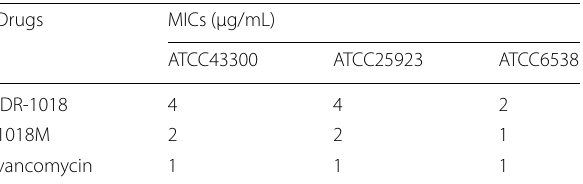
Table 2 The MICs of IDR-1018, 1018M and vancomycin against S.